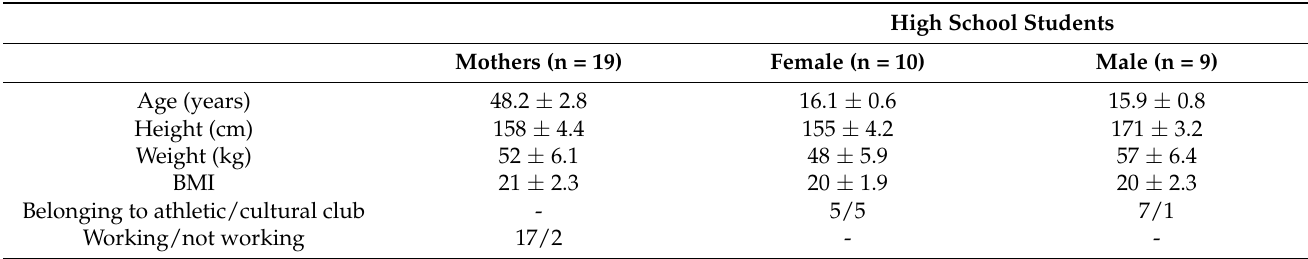
Table 7. Physical characteristics of the